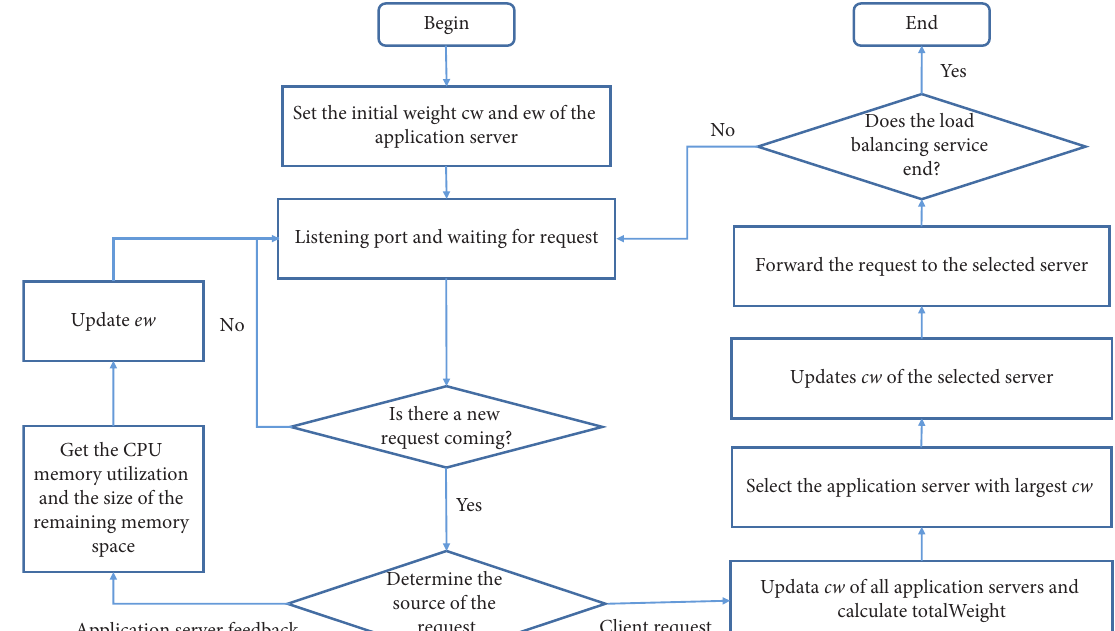
Figure 4: Flowchart of the dynamic load balancing